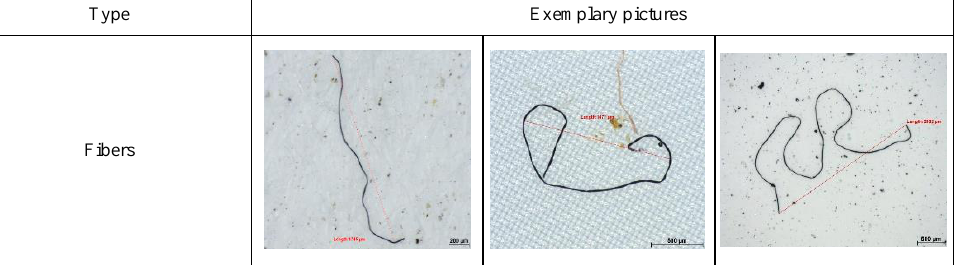
Fig. 4. Examples of